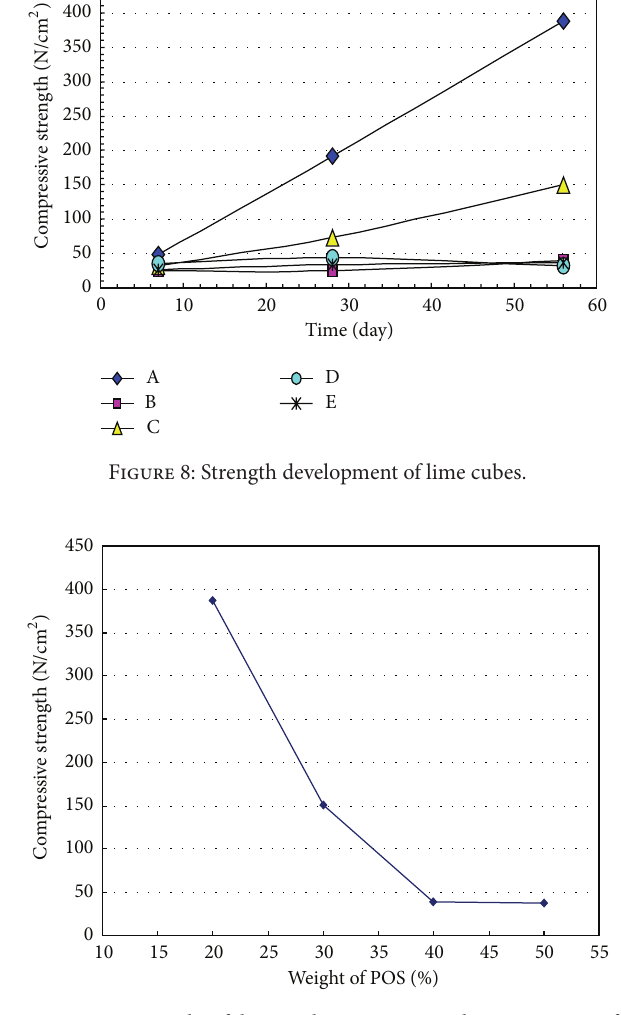
Figure 9: Strength of lime cubes versus weight percentage of pulverized oyster shell.